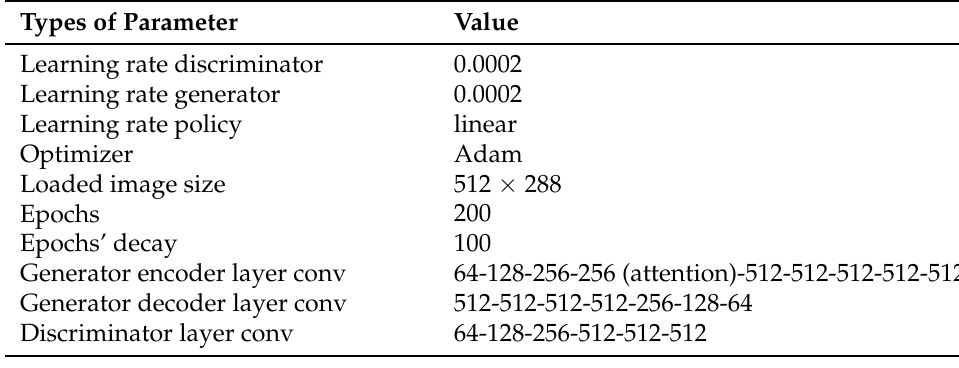
Table 1. Values of the parameters.